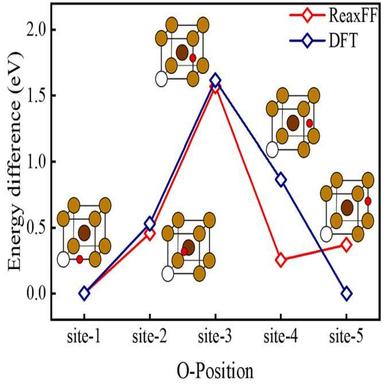
The energy difference (calculated by present ReaxFF and DFT) of a single O occupying different octahedral interstitial positions in the presence of mono-vacancy and substitute Cr atom.